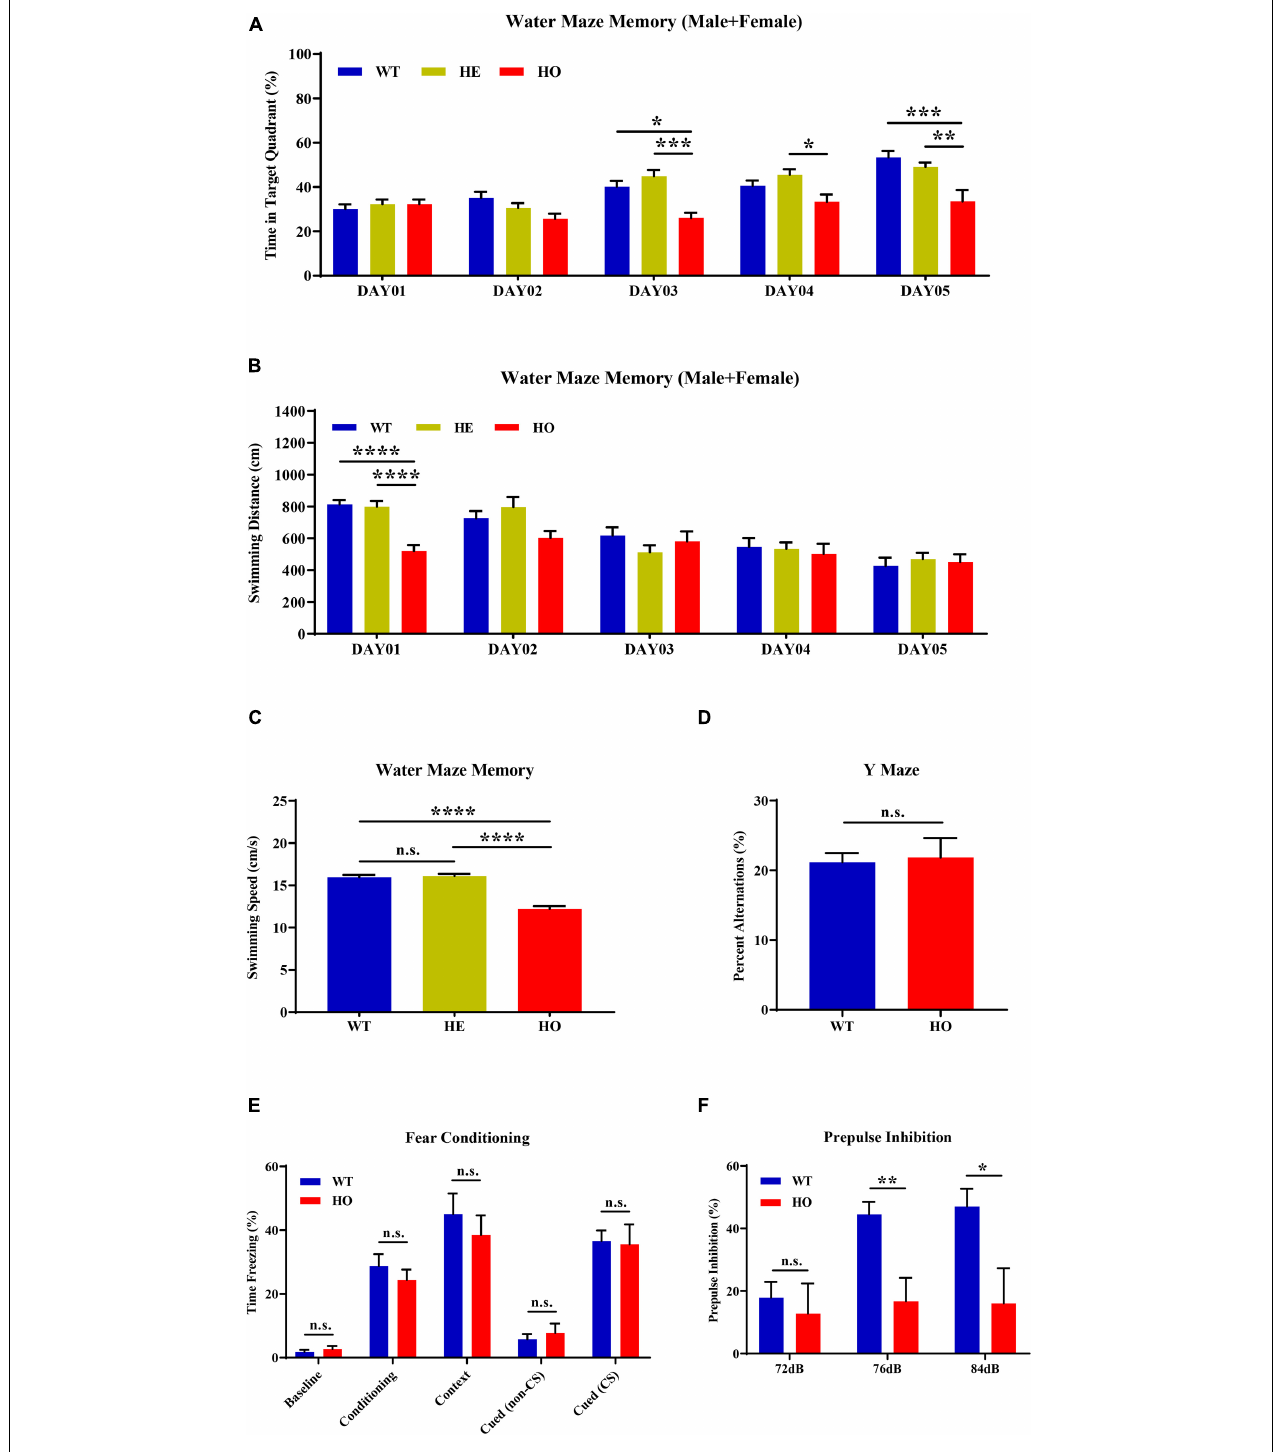
FIGURE 3 | Spatial learning memory and prepulse inhibition (PPI) impairments in Slc20a2 -deficient mice. (A,B) Spatial learning and memory ability revealed by the Morris water maze (MWM) test in the following dimensions: (A) spending time in the target quadrant (%) in each day trial. (B) Total swimming distance (cm) in each day trial. (C) Average mice swimming speed (cm/s) in all MWM experimental trials during 5 days. (D) The alternation score in spontaneous alternation Y-maze. (E) Fear memory revealed by freezing time (%) under different stimuli and environment. (F) The percentage score of PPI, reflecting the sensorimotor function of experimental mice. WT, wild Slc20a2 genotype; HE and HO, heterozygous and homozygous Slc20a2 gene trapping/knockout; * p < 0.05; ** p < 0.01; *** p < 0.001; **** p < 0.0001; n.s., not statistically significant.